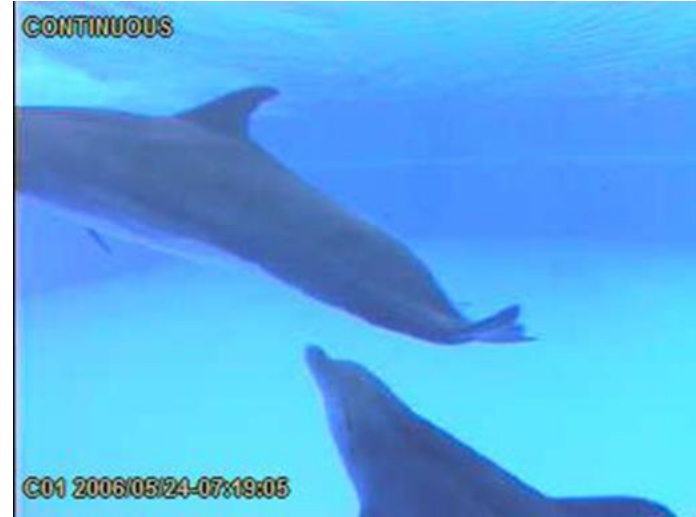
Figure 11 . Genital tracking (GT) of animal 1 by animal 4.